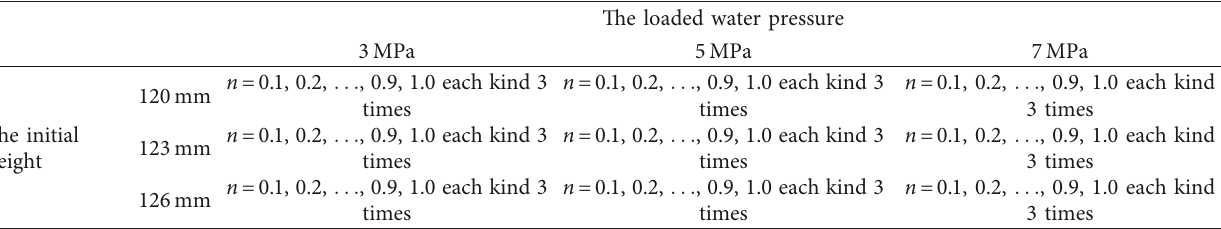
Figure 7: The main components of the data acquisition-analysis subsystem. (a) Data collector, (b) pressure transducer, (c) flow transducer, and (d) pressure gauge. Table 1: The experimental